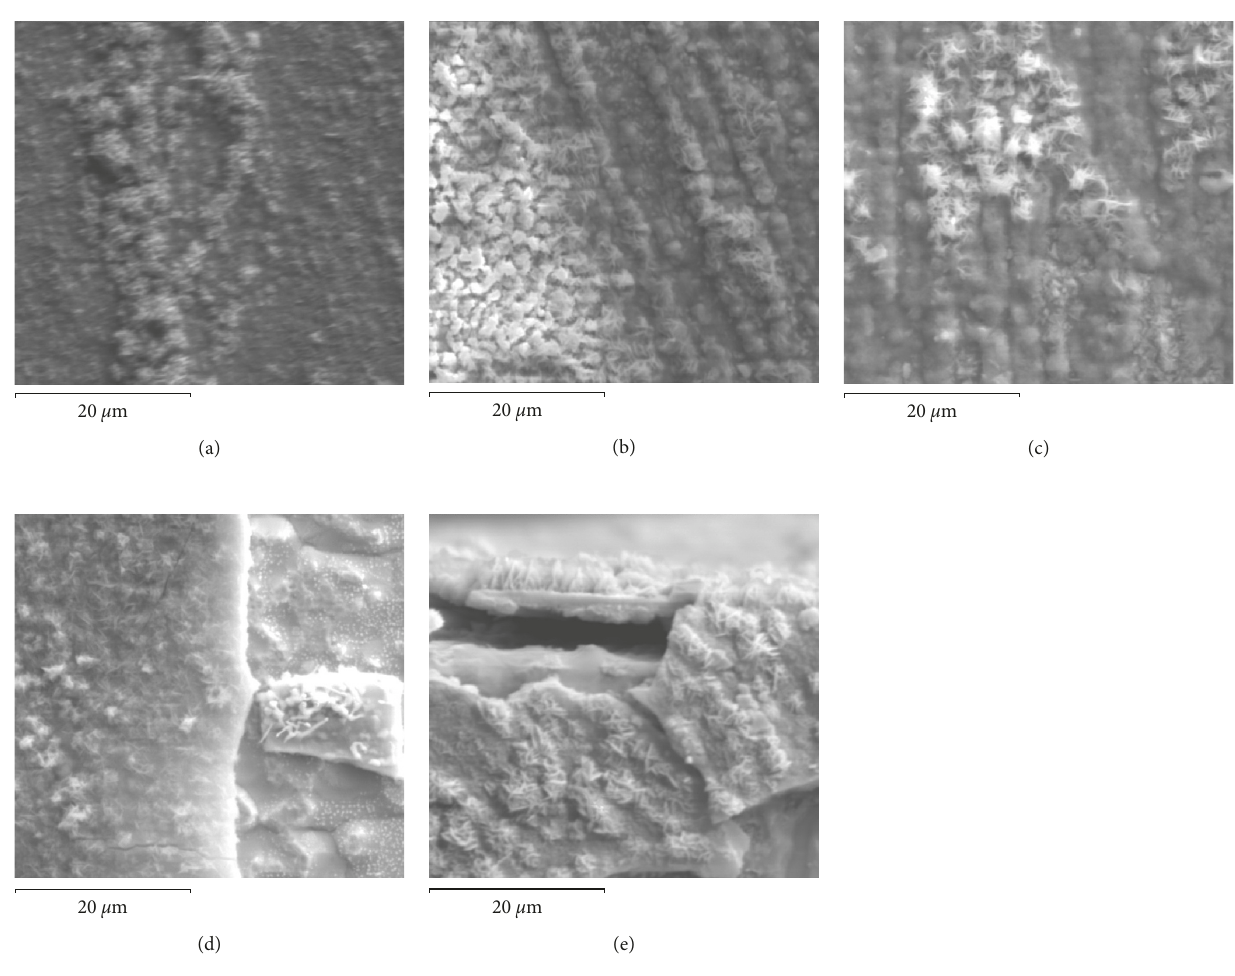
3 Al, (b) Ni 3 Al +1.0% Ag, (c) Ni 3 Al +1.0%